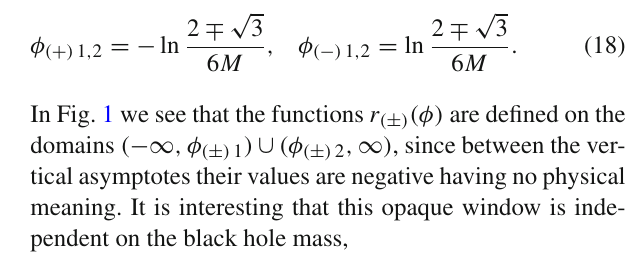
The spiral geodesics are symmetric, r ( ± ) (φ) = r ( ∓ ) ( − φ)